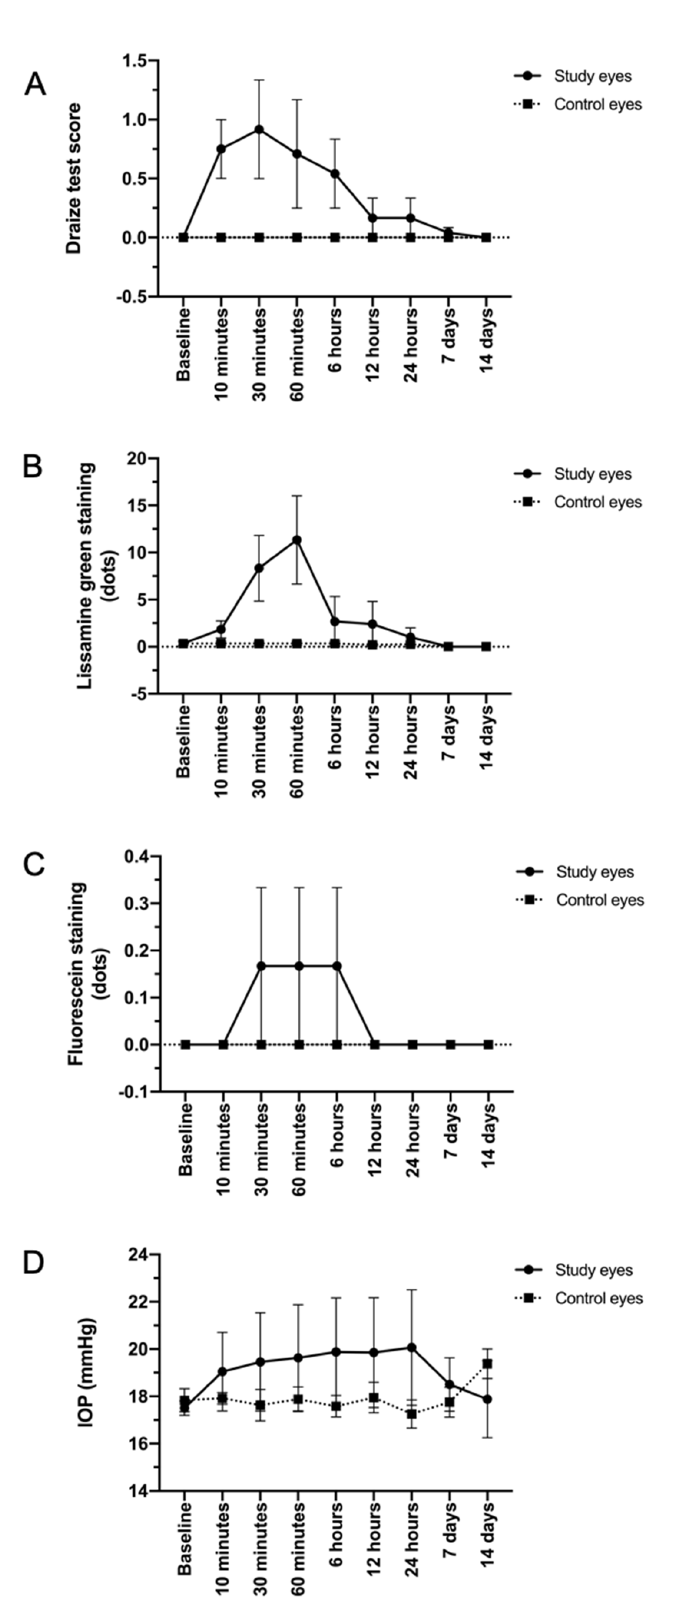
Figure 1. Mean Draize test scores ( A ), staining scores ( B , C ), and intraocular pressure ( D ) in study and control eyes. Non-significant differences were observed between eyes treated with triamcinolone acetonide-loaded liposomes formulation and control eyes receiving an instillation of saline-balanced solution during the follow-up.